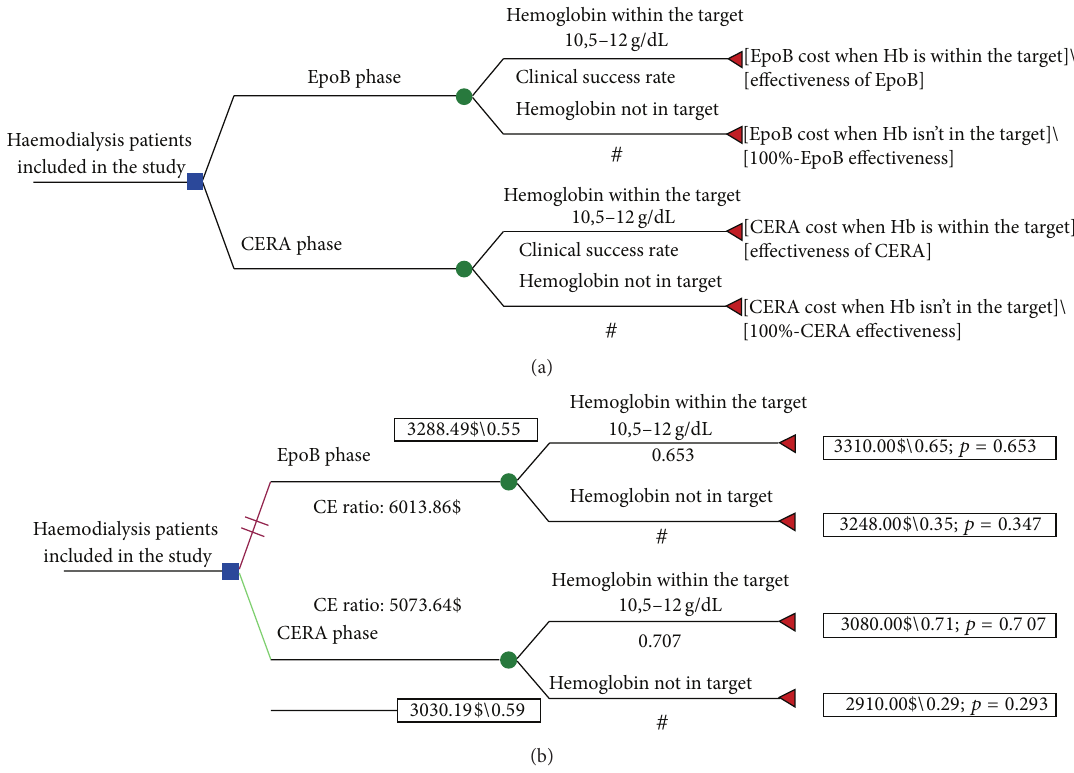
Figure 3: (a) Decision tree framework. (b) Results of cost-effectiveness analysis after roll-back calculation. EpoB: recombinant human